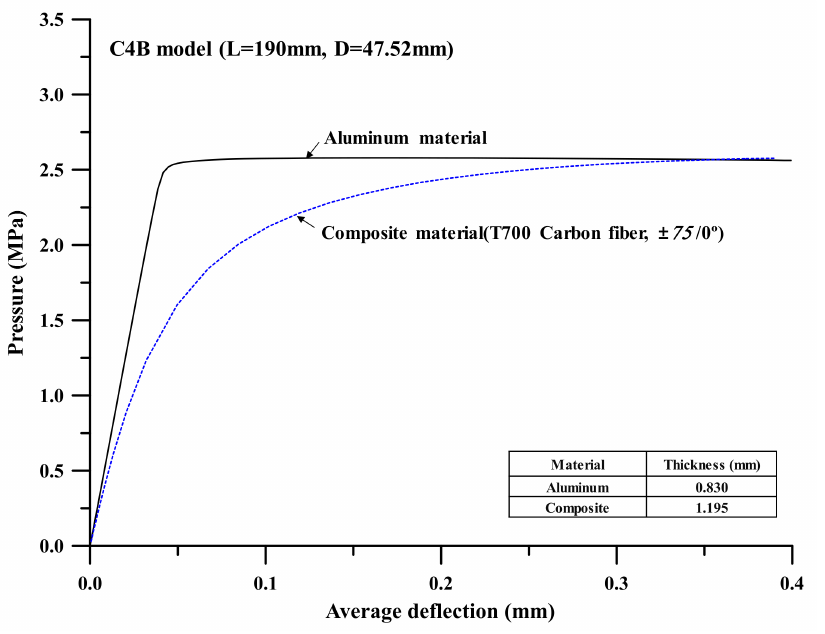
Figure 11. Search for the same collapse strength in the composite material model (See Table 7).